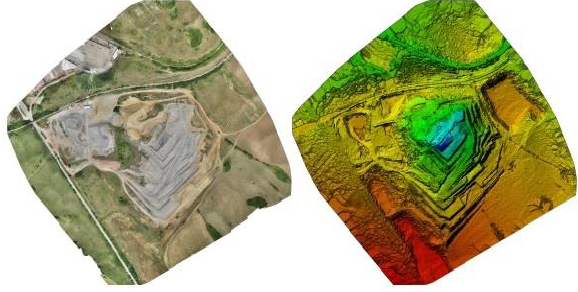
Figure 8. Orthomosaic and Digital Surface Model (DSM) of the quarry